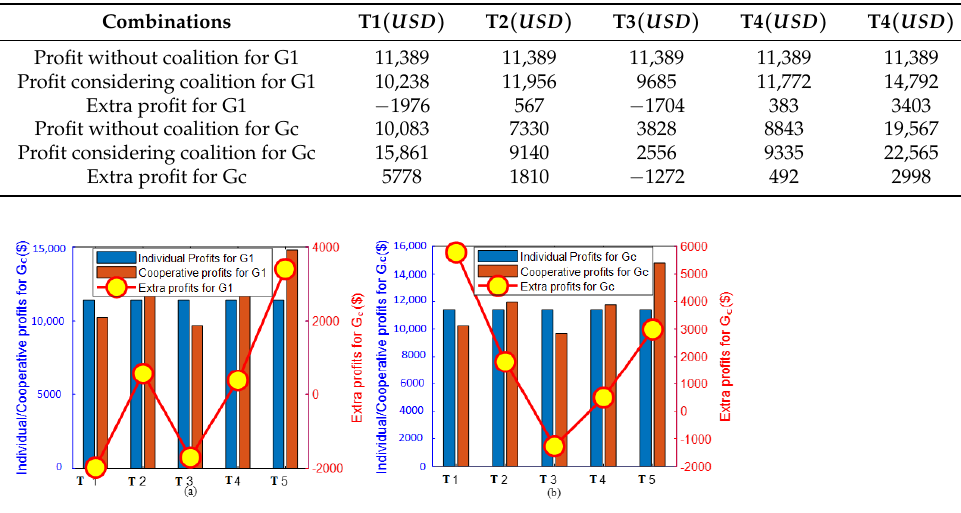
Figure 13. ( a ) The profit of wind power supplier under the coalition. ( b ) The profit of cooperative power suppliers under the